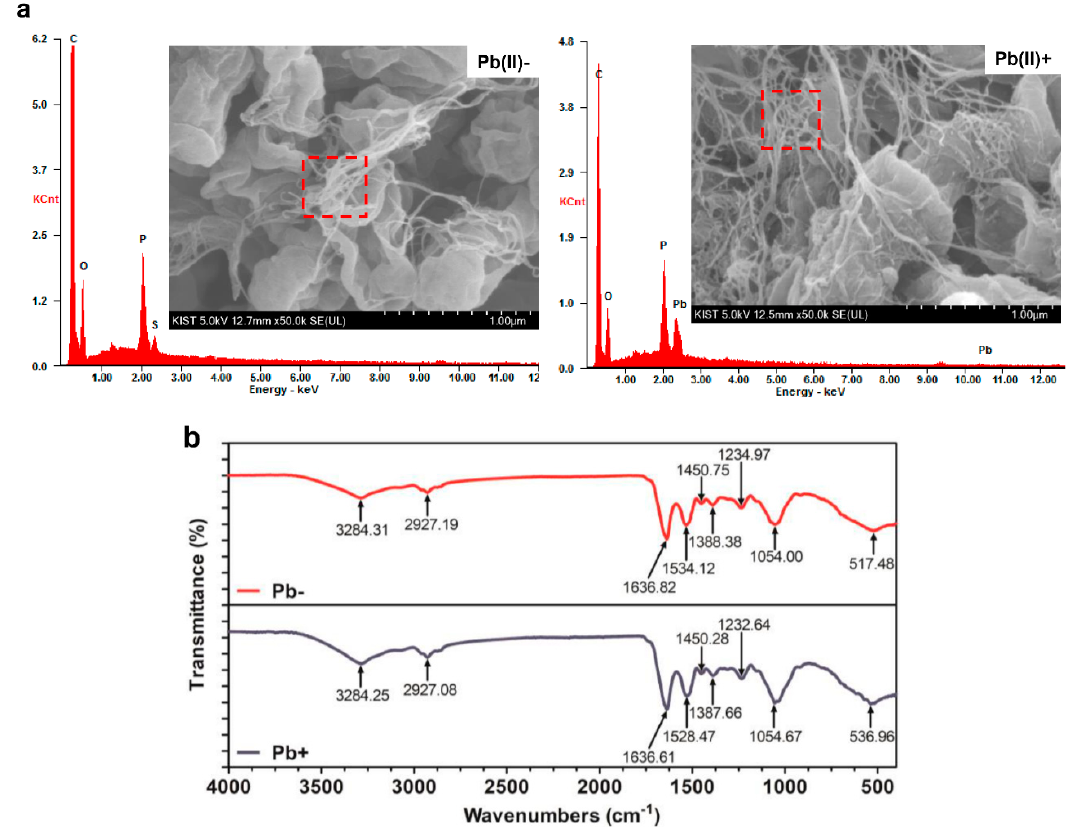
Figure 4. ( a ) SEM-EDX and ( b ) FTIR spectra of the EM2 strain before and after adsorbing Pb(II). The dashed red square indicates the region of the EDX scan. The experimental conditions were as follows: Pb(II) concentration of 10 mg/L, biomass dosage of 1 g/L, pH 7, and contact time of 60 min.